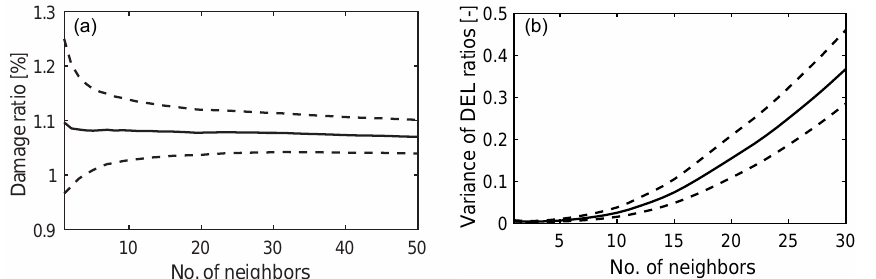
Figure 3. (a) Estimation error of lifetime damage as function of number of neighbors considered in the extrapolation algorithm. (b) Variance of individual DEL ratios as function of number of neighbors. DEL ratios are calculated as “extrapolated M-DEL/simulated